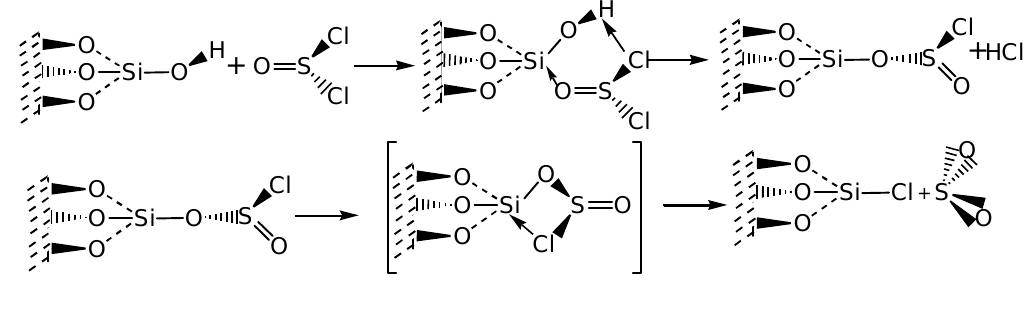
Figure 1. Chemisorption of thionyl chloride on silica